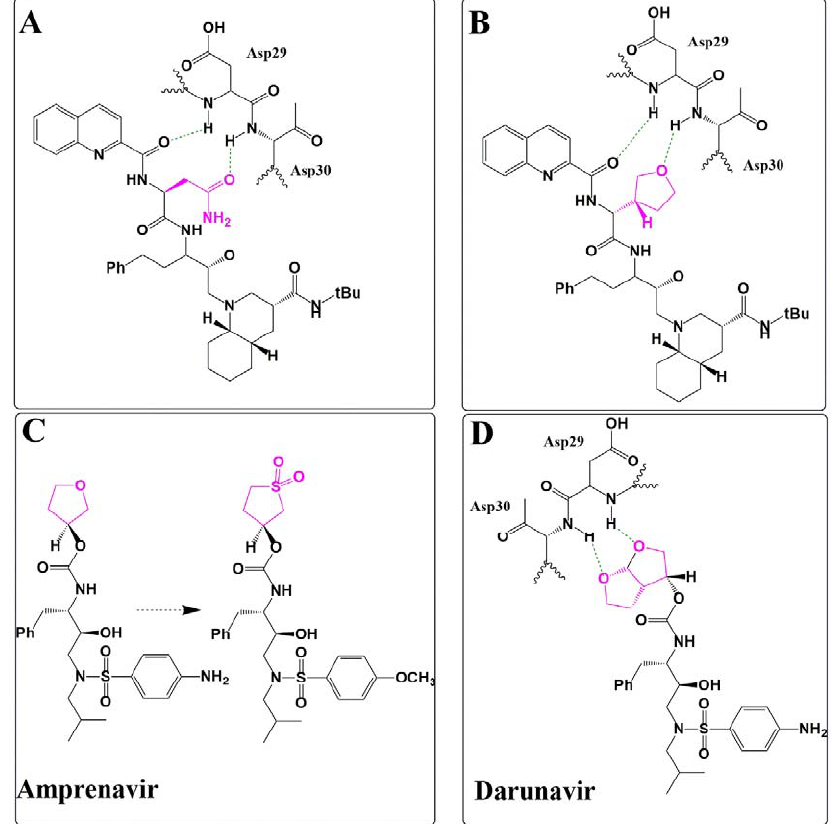
Figure 5. HIV ‐ 1 protease inhibitor interaction. ( A ) Saquinavir interacts with the HIV ‐ 1 protease Figure5. HIV-1proteaseinhibitorinteraction. ( A )SaquinavirinteractswiththeHIV-1proteasebackbone backbone residue Asp29 and Asp30. ( B ) Asparagine moiety in (A) was replaced by 3(R) ‐ residue Asp29 and Asp30. ( B ) Asparagine moiety in (A) was replaced by 3(R)-tetrahydrofuranylglycine tetrahydrofuranylglycine (in pink) to obtain Amprenavir. ( C ) A cyclic sulfone group, in which the (in pink) to obtain Amprenavir. ( C ) A cyclic sulfone group, in which the oxygen can accept H bonds from oxygen can accept H bonds from both Asp29 and Asp30 and retain crucial backbone interactions. ( D ) both Asp29 and Asp30 and retain crucial backbone interactions. ( D ) Darunavir backbone interaction Darunavir backbone interaction with the HIV ‐ 1 protease (PDB code: 2F81) . with the HIV-1 protease (PDB code: To potentially improve bioavailability, Gosh and colleagues replaced this 3(R) ‐ tetrahydrofuranylglycine moiety in amprenavir (K i = 160 nM) with a cyclic sulfone group, in which the oxygen can accept H bonds from both Asp29 and Asp30 (Figure 5 C) with retained potency (K i = 1.4 nM). To retain the ability to address both asparagines, further optimization did lead to the design of a more lipophilic bicyclic ether as a sulfone isostere, within the highly potent protease inhibitor